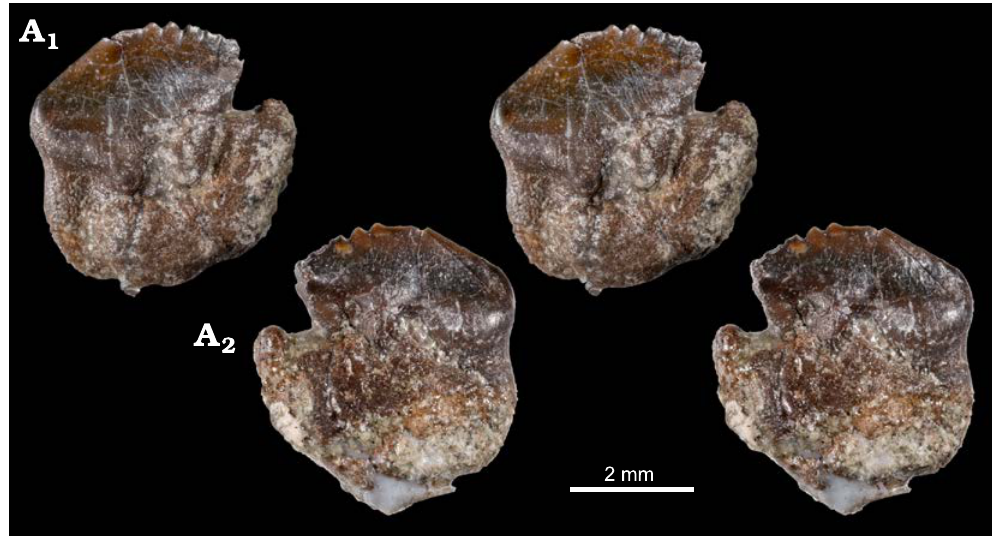
Fig. 2. Left p4 in dentary fragment, NMV P216655, holotype of the cimolodontan multituberculate Corriebaatar marywaltersae Rich, Vickers-Rich, Flannery, Kear, Cantrill, Komarower, Kool, Pickering, Trusler, Morton, van Klaveren, and Fitzgerald, 2009, Flat Rocks locality, Eumeralla Formation, Barremian, Lower Cretaceous of Victoria, Australia; stereopairs in buccal (A 1 ) and lingual (A 2 )